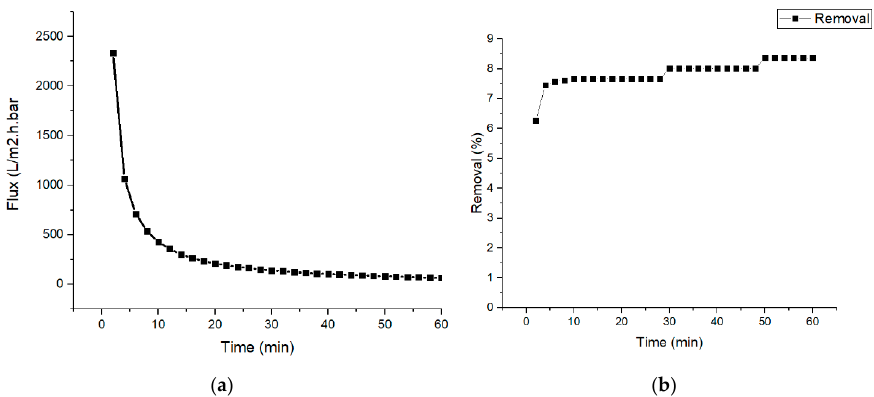
Figure 4. ( a ) Nylon 6,6 nanofiber membrane flux for the 10 ppm dye solution and ( b ) the percentage removal of the 10 ppm celestine blue dye by the nylon 6,6 nanofiber membrane.